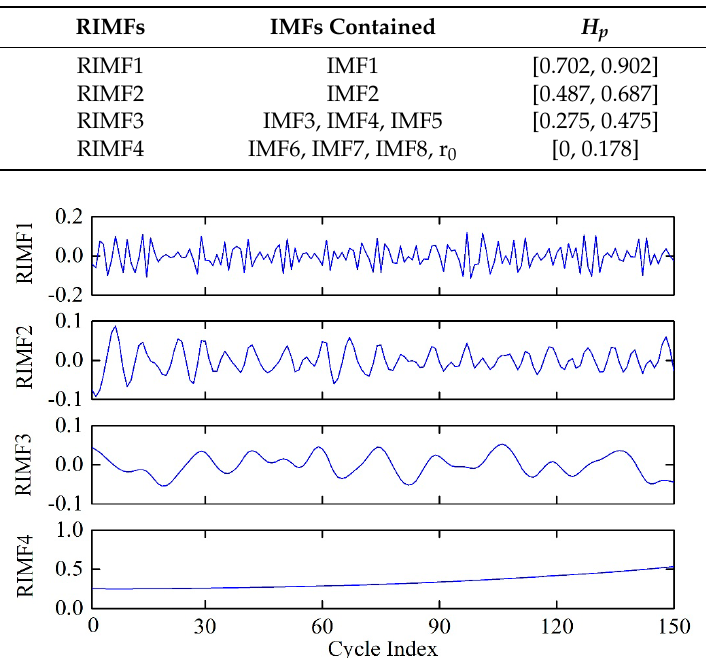
Figure 7. Refactored IMFS (RIMFs) from fast ensemble empirical mode decomposition (FEEMD) decomposition results.